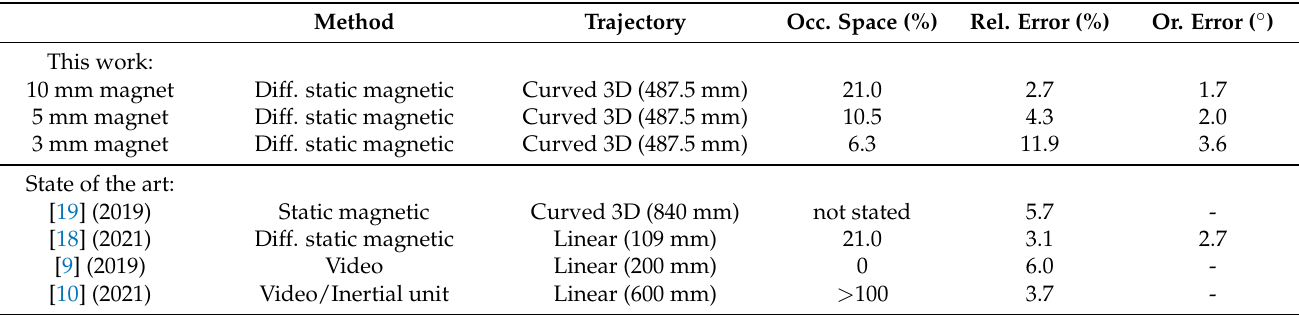
Table 1. Comparison with state-of-the-art capsule endoscopy tracking methods. The occupied space is specified with respect to the assumed typical size of commercial capsules of 33 (length ×